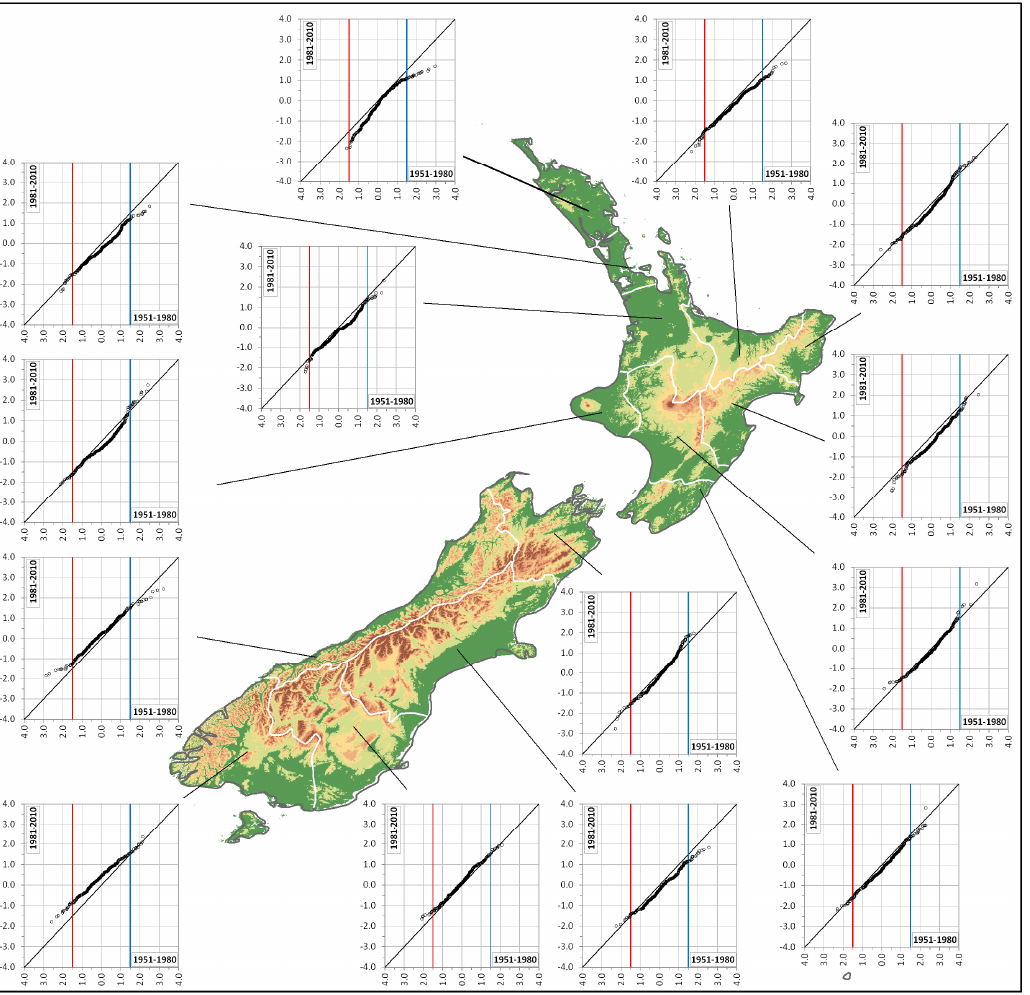
Figure 5. Regional results of the ITA method applied to the 6-month SPI.